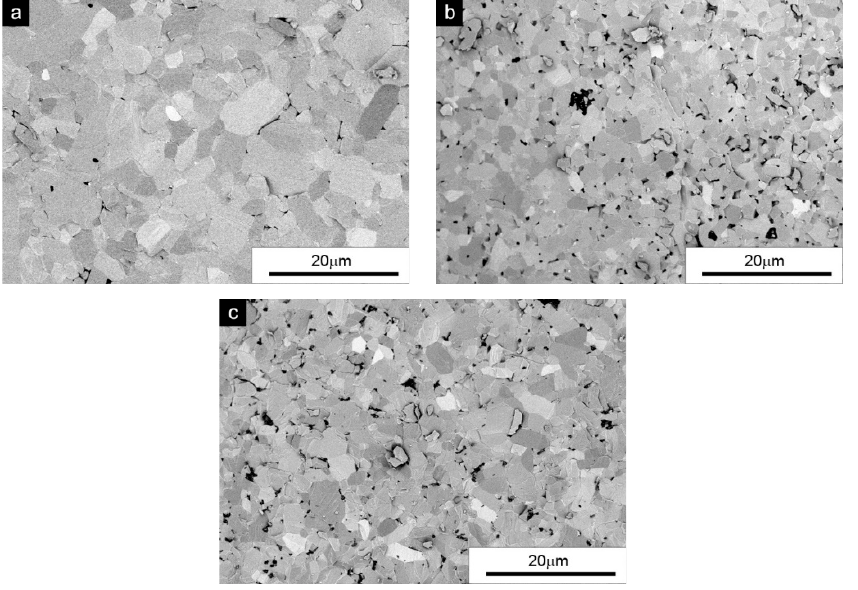
Figure 3. Microstructure of SiC sinters’ fractures for the starting powders with an α / β ratio of 50/50: ( a ) carbon-free SiC, ( b ) SiC-G graphene addition and ( c ) SiC-CB carbon black addition.